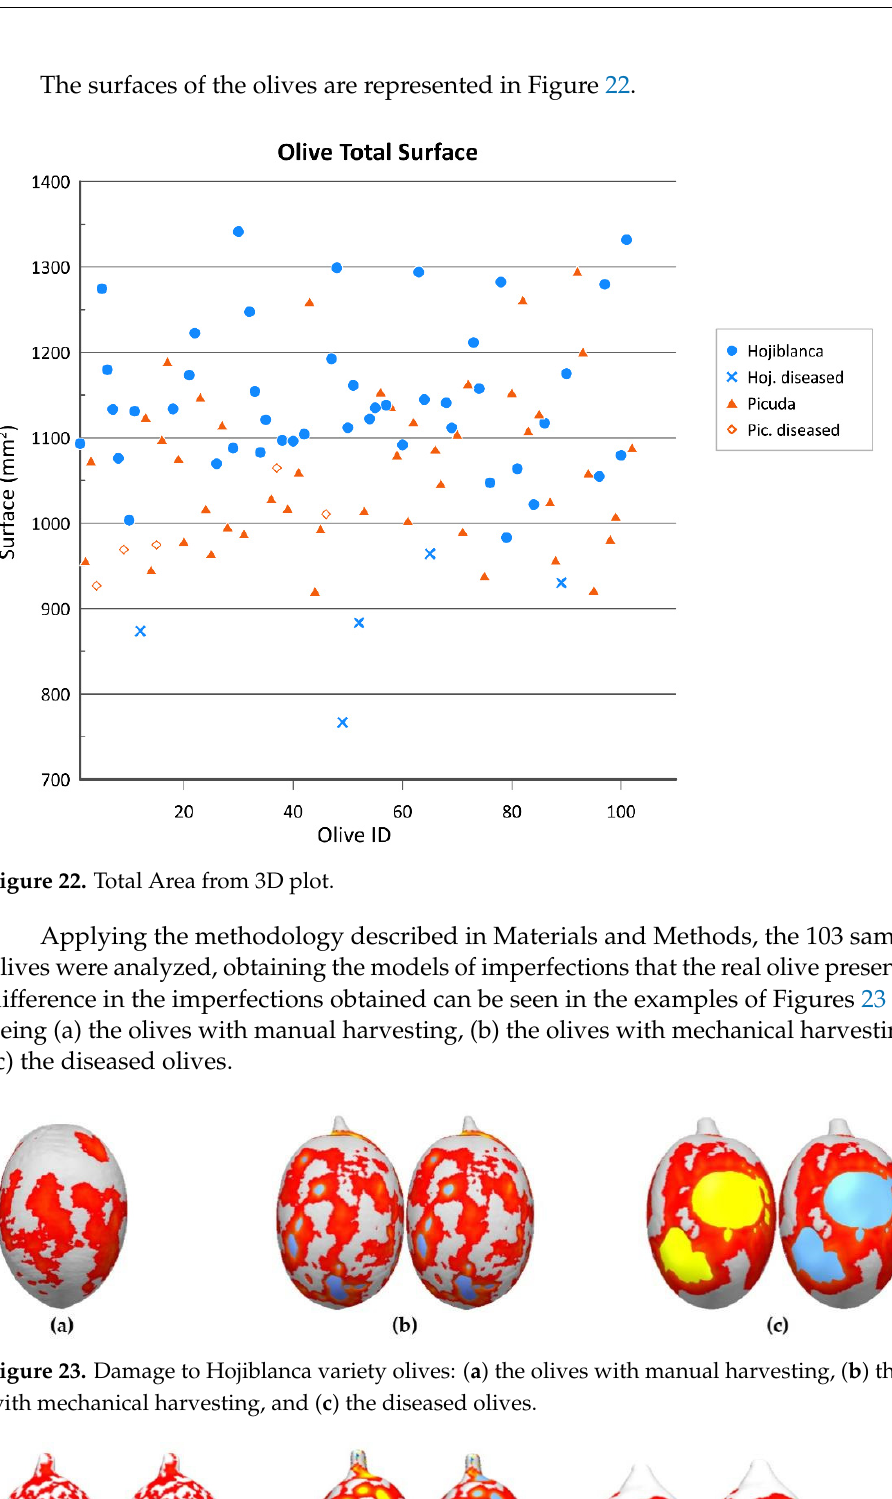
Figure 21. Total Volume plot. The surfaces of the olives are represented in Figure 22. The surfaces of the olives are represented in Figure 22.